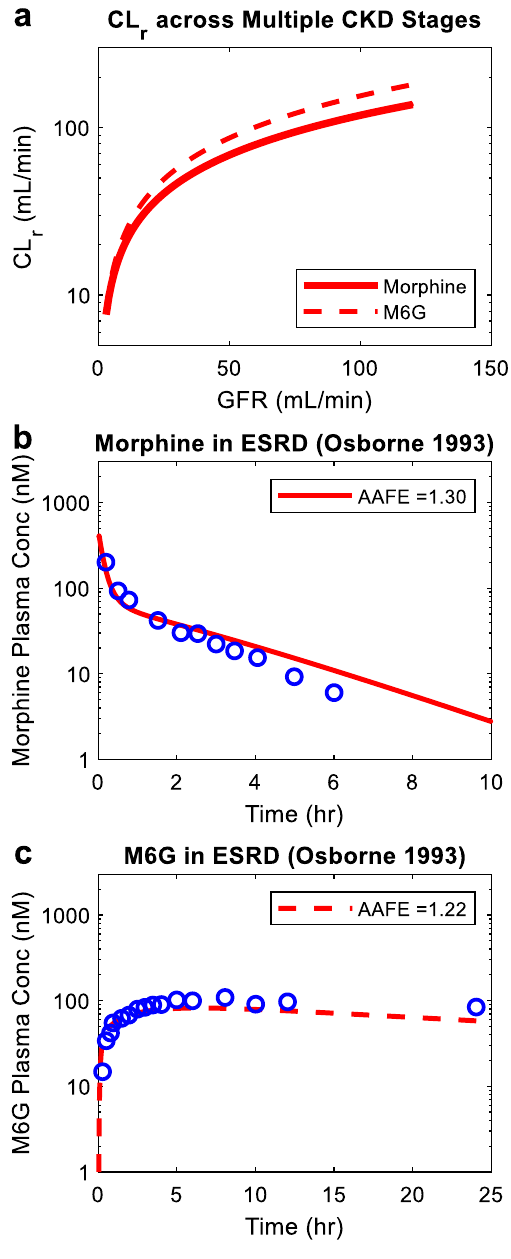
Figure 5. Simulation of morphine and M6G renal clearance and plasma concentration–time profiles in chronic kidney disease patients. The renal clearance (CL r in mL/min) of morphine (red solid curve) and M6G (red dashed curve) was simulated at multiple stages of chronic kidney disease (CKD) reflected by varying glomerular filtration rate (GFR in mL/min) using novel in silico adaptive CKD model 15 together with experimentally determined permeability and active secretion via VPT-MPS (panel a ). The plasma morphine concentration– time profile was simulated after intravenous dosing of morphine (shown in red solid curves) in end stage kidney disease (ESKD) patients in comparison to the observed data 13 (panel b ). The last observed data point from the study 13 was not used since it was greatly below the lower limit of detection (1 ng/mL or 3.5 nM). The plasma M6G concentration–time profile was simulated as a metabolite (shown in red dashed curves) in end stage kidney disease (ESKD) patients after intravenous dosing of morphine in comparison to the observed data 13 (panel c ). All simulation results are shown in red, and all observed data are shown in blue open circles. The calculated absolute average fold error value for each panel is shown in the